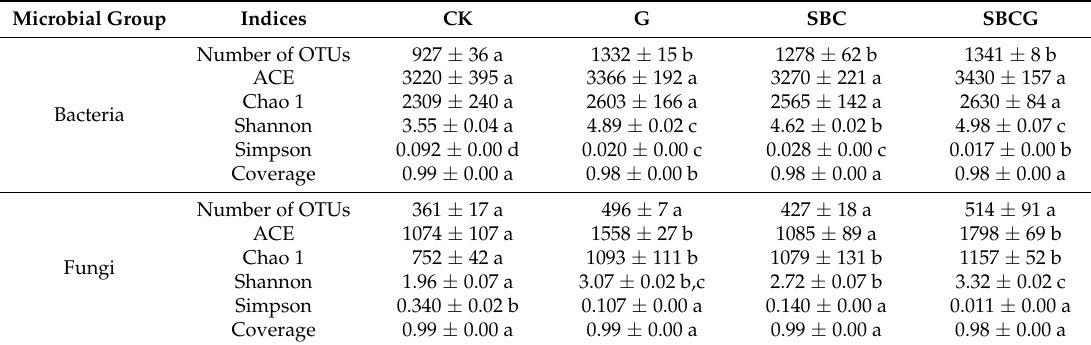
Table 3. Summary of the number of bacterial and fungal sequences, number of operational taxonomic units (OTUs), α -diversity indices (based on 97% OTUs) and coverage in four treatments (mean ± S. V. (standard deviation), n =